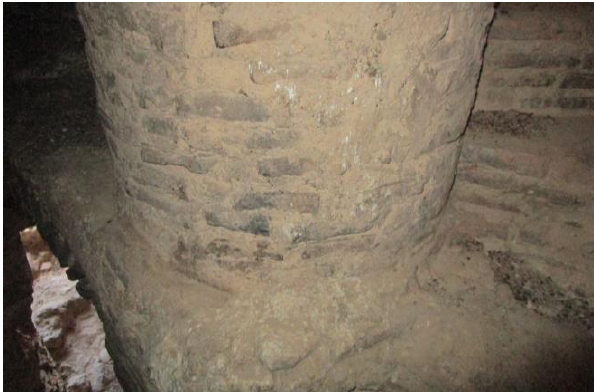
Figure 12. Point at which the central abutment becomes circular.